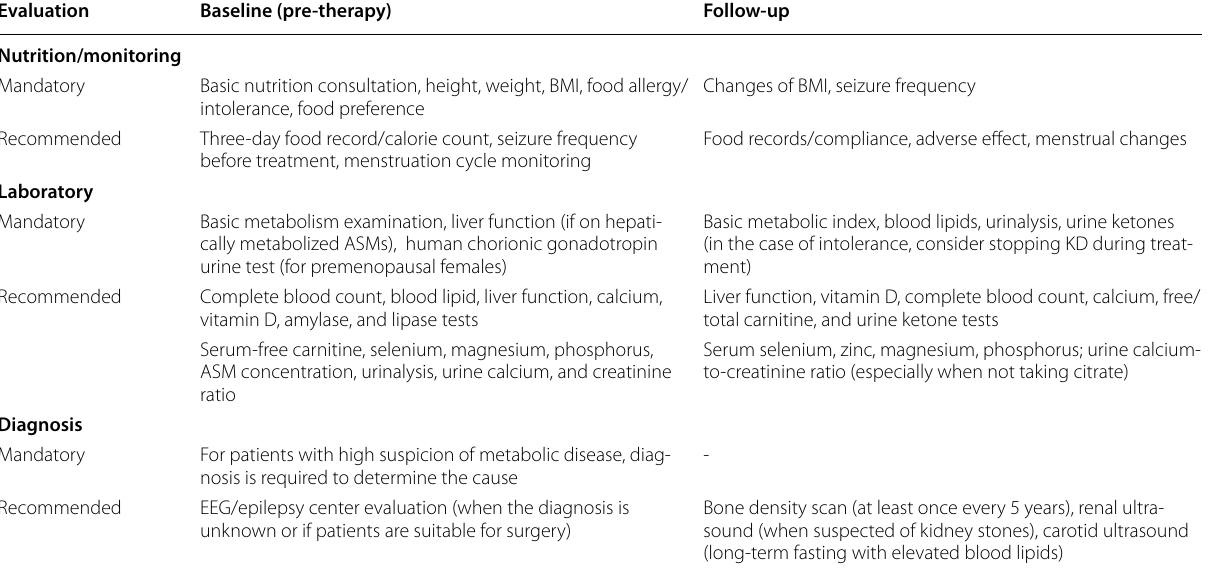
ASM anti-seizure medication, BMI body-mass index, EEG electroencephalogram, KD ketogenic dietary